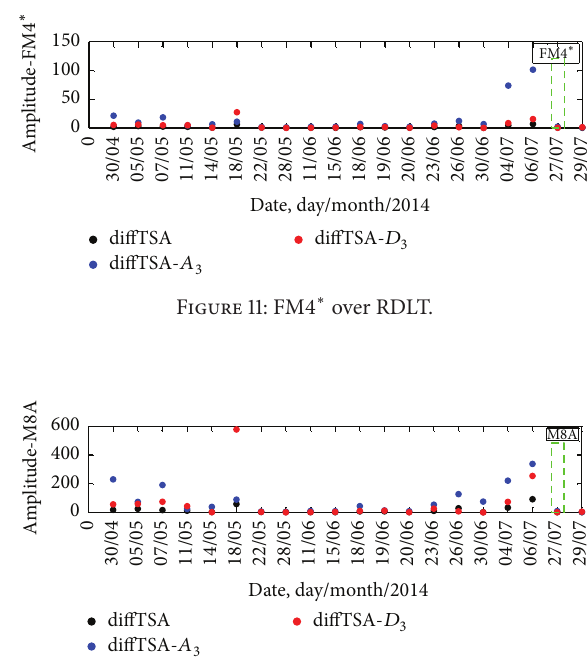
Figure 10: NA4 ∗ over RDLT.